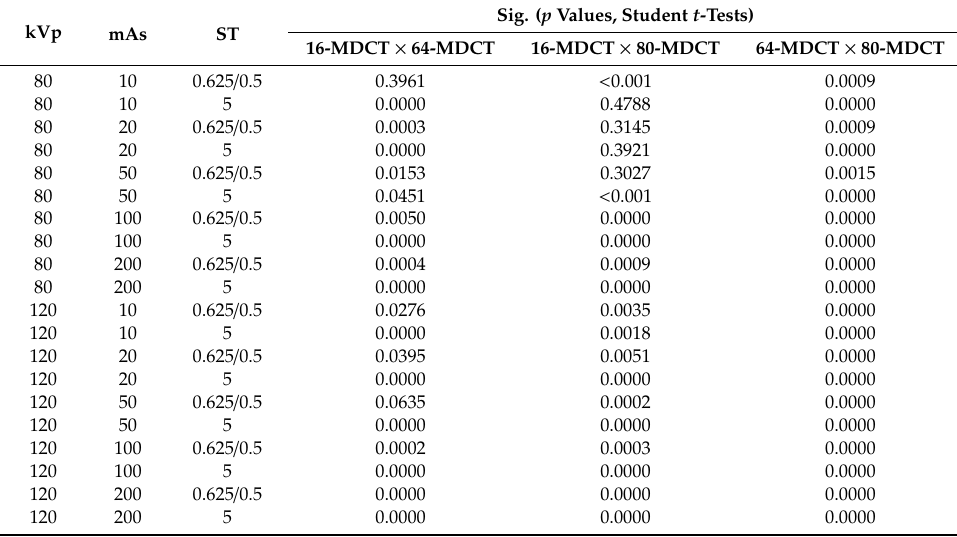
Figure 3. Thicker slice images resulted in higher CNR values at 80 kVp with di ff erent mAs levels for the 80-MDCT scanner. (Note the change in CNR values at 10 mAs among 1-, 2- and 5-mm slice thickness images and the change in CNR values at 50 mAs between 1- and 2-mm slice thickness images.) Table 9. Dissimilarities ( p values, student t -tests) between images of the same factors and section thicknesses utilising various CT scanners.